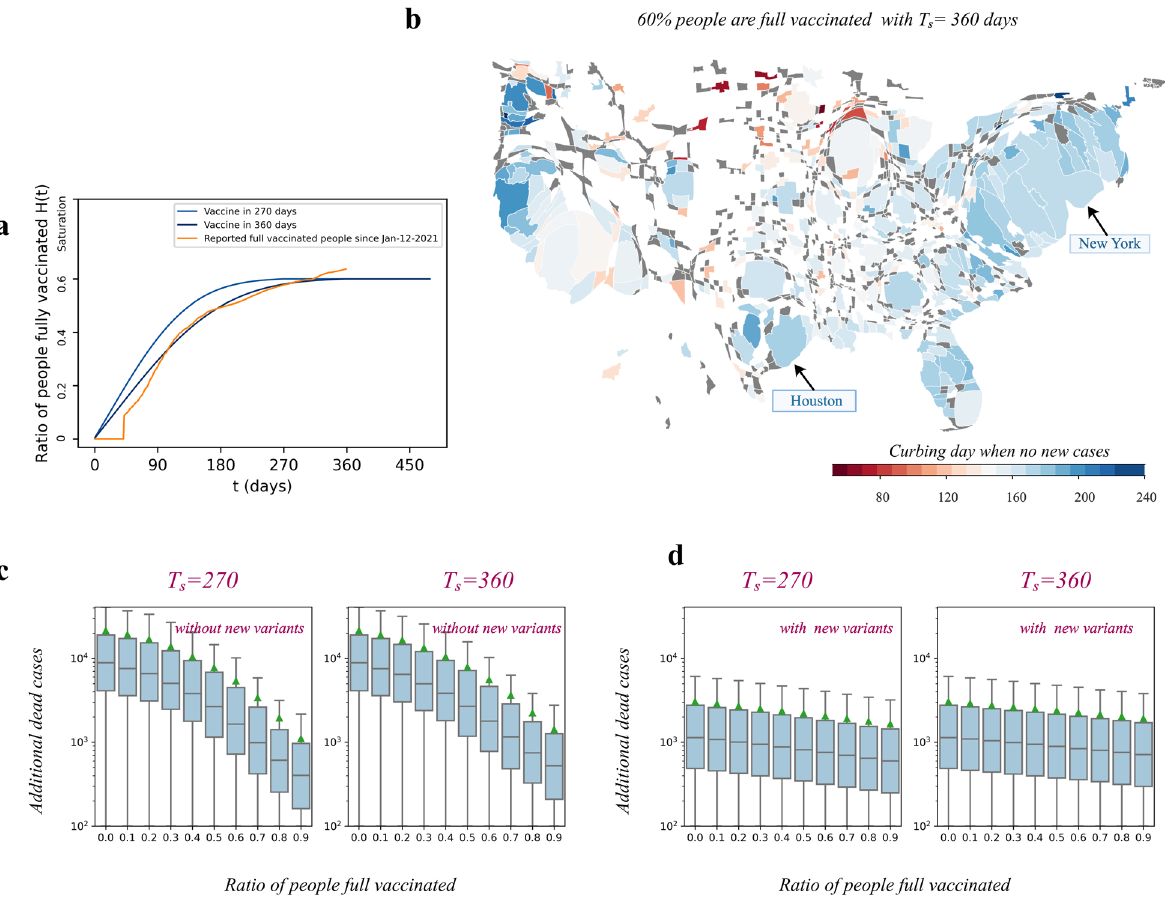
Fig. 6 Disease severity with/without variants of concern. By (1) de fi ning the day reaching zero new infection for 90 days as the curbing day, (2) assuming that interventions (i.e., stay-at-home order, face-mask wearing, and testing) keep the same as that from 5 January 2021 to 11 February 2021, (3) consider the ratio of people fully vaccinated as the vaccination coverage, we test the curbing days for MSAs since 12 January 2021. a The vaccination adoption model H ( t ) illustrates how the saturation of people fully vaccinated is reached in period T s . Speci fi cally, the orange line is the reported cumulative vaccination coverage. b MSAs' estimated curbing days if 60% are full vaccinated with 360 days. c , d Box plots for MSAS' additional death in the following 1000 days for different saturation of vaccination coverage with/without the presence of